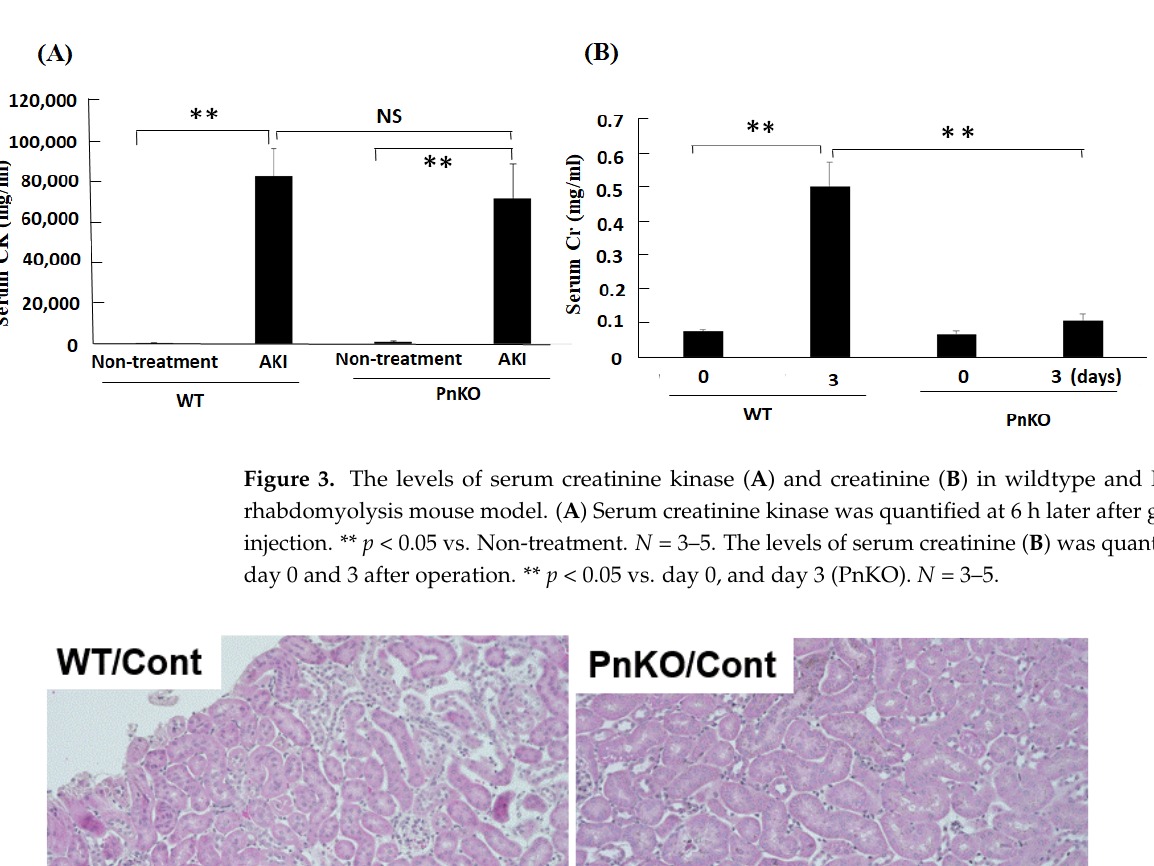
Figure 3. The levels of serum creatinine kinase ( A ) and creatinine ( B ) in wildtype and Pn-null rhab- domyolysis mouse model. ( A ) Serum creatinine kinase was quantified at 6 h later after glycerol injection. ** p < 0.05 vs. Non-treatment. N = 3 – 5. The levels of serum creatinine ( B ) was quantified at day 0 and 3 after operation. ** p < 0.05 vs. day 0, and day 3 (PnKO). N = 3 – 5.